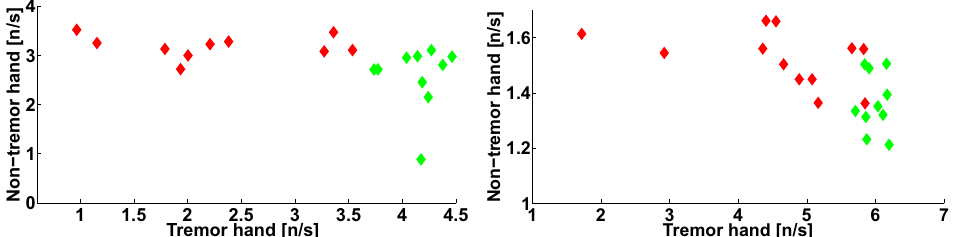
Figure 22. The scatter plot of the numbers of wave trains per second detected in the physiological tremor frequency band in the extensor muscle of the tremor and non-tremor arms of the PD patients. The abscissa axis indicates the wave train numbers corresponding to the physiological tremor in the tremor hand; the ordinate axis indicates the wave train numbers corresponding to the physiological tremor in the non-tremor hand. The PD patients are indicated by the red color; the control subjects are indicated by the green color. On the left, the left-hand-tremor PD patients are shown. On the right, the right-hand-tremor PD patients are shown.